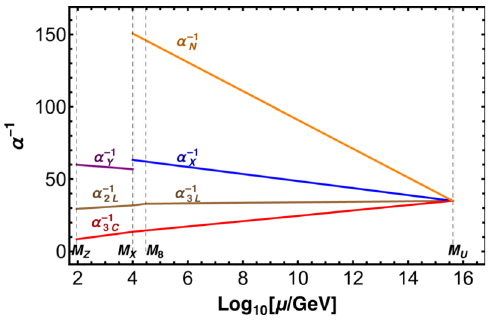
Figure 6 . An example of SU(3) c × SU(3) L × U(1) X × U(1) N unification for a phenomenologically accessible 3-3-1-1 symmetry breaking scale M to the dashed curves in figure